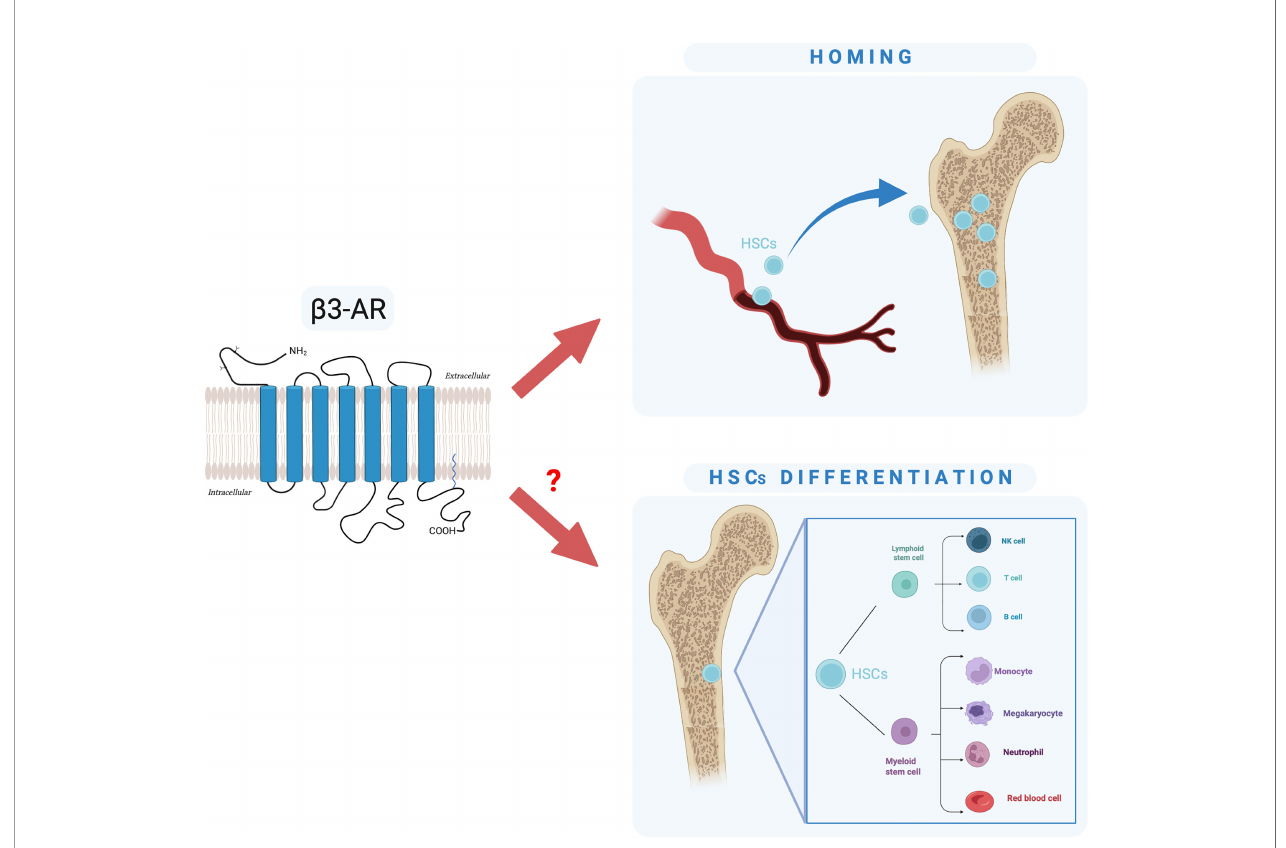
FIGURE 5 | Schematic representation of our hypothesis: is b 3-AR involved in HSC homing and